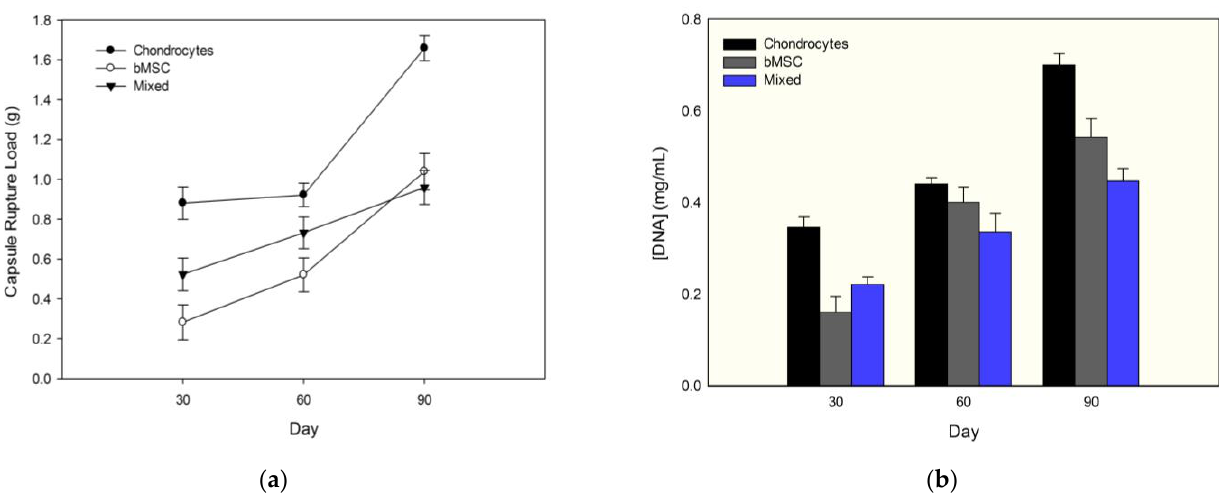
Figure 14. Quantitative measurements of the changes over the 90-day encapsulation culture to ( a ) the PECM rupture strength and ( b ) cellular DNA content. Error bars indicate the standard deviation.